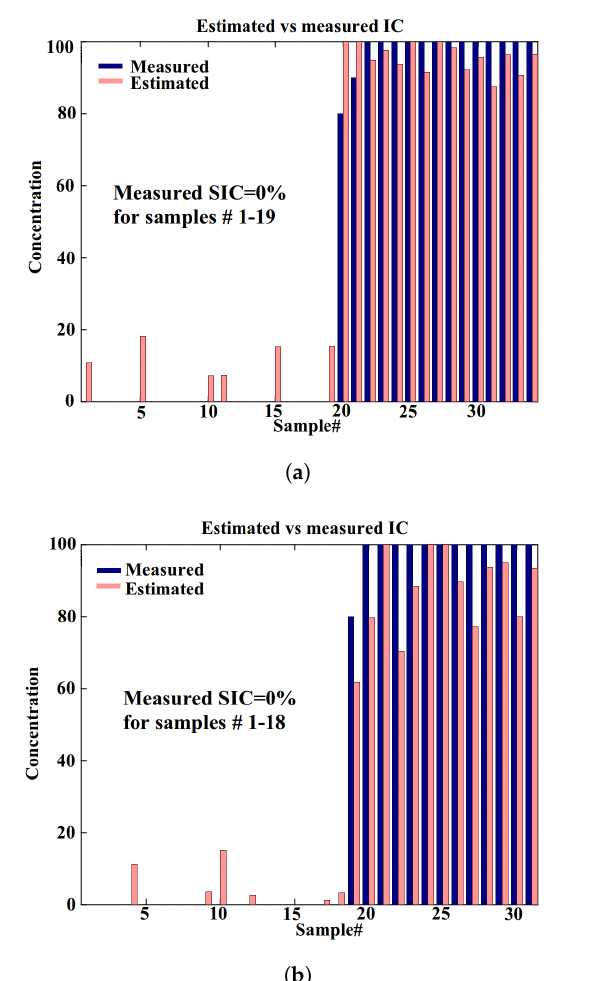
Figure 10. SIC estimation results for ( a ) the training data and ( b ) the test data using five features. The SIC values have been ordered into ascending order (from left to right) based on the in-situ SIC value; i.e., the low SIC values (short bars) are on the